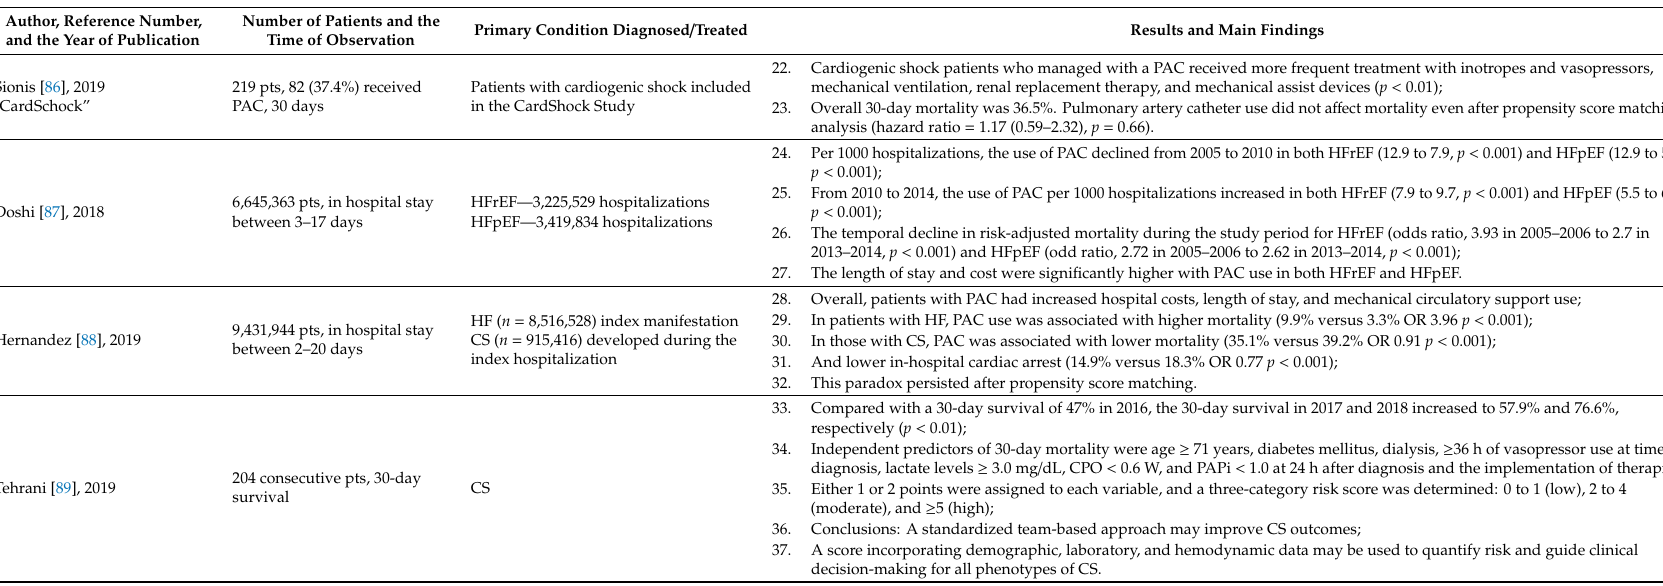
Table legend: PAC—pulmonary artery catheter, CVC—central venous catheter, ALI—Acute Lung Injury, HR—Hazard ratio, OR—Odds ratio, CI—confidence interval, HFrEF / HFpEF—heart failure with reduced / preserved ejection fraction, CS—cardiogenic shock, CPO—cardiac power output, PAPi—pulmonary arterial pulsatility